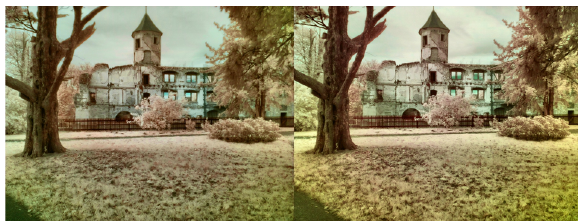
Figure 11: Saturation extended, cross view stereo